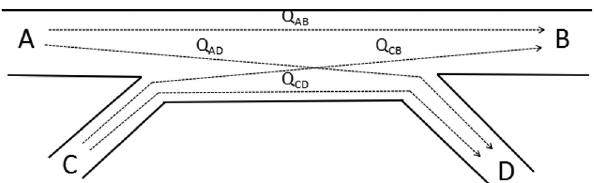
Figure 2 Composition of the weaving segment and the fl ow direction of the traf fi c fl